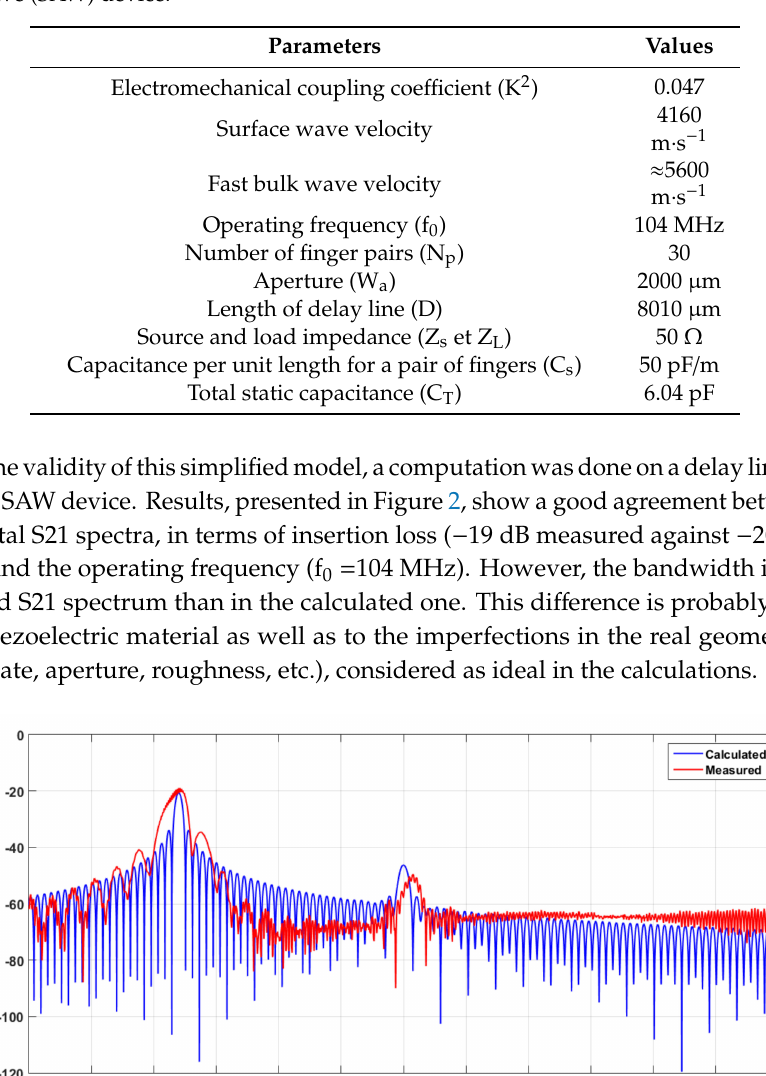
Table 1. Input parameters implemented in MATLAB software to model a LiTaO 3 -104 MHz surface acoustic wave (SAW) device.